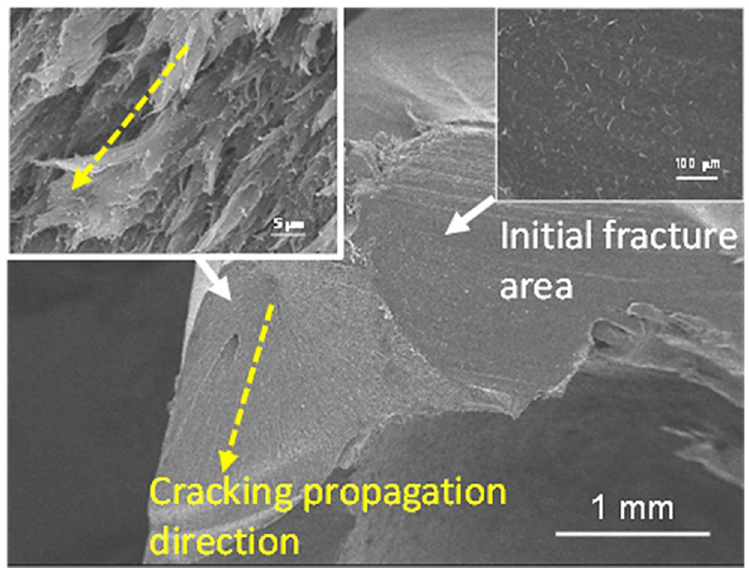
Figure 7. SEM microscopic observation of fracture morphology of the TiO 2 -free PEEK crown after compression test (yellow arrow indicates the direction of cracking propagation).